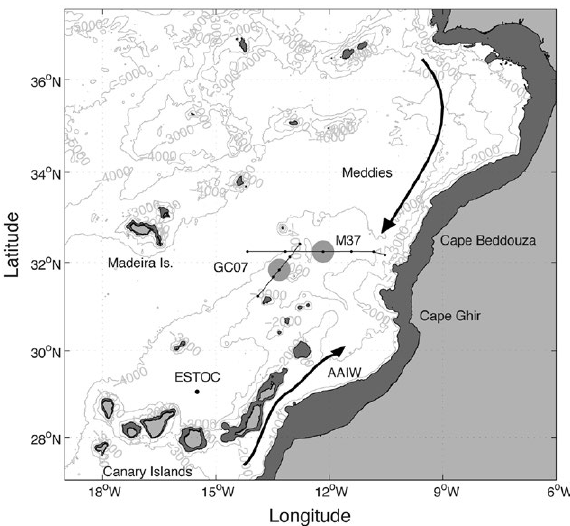
Fig. 1. – Canary Basin north of the Canary Islands, showing the bathymetry and main geographic features; the arrows illustrate the southward mean trajectory of meddies and the northward propaga- tion of AAIW. The hydrographic sections that sampled meddies during the Meteor-37 and Canoa07 cruises are shown together with the approximate location of meddies M37 and GC07, drawn as grey circles, and the position of the ESTOC mooring, drawn as a black dot.